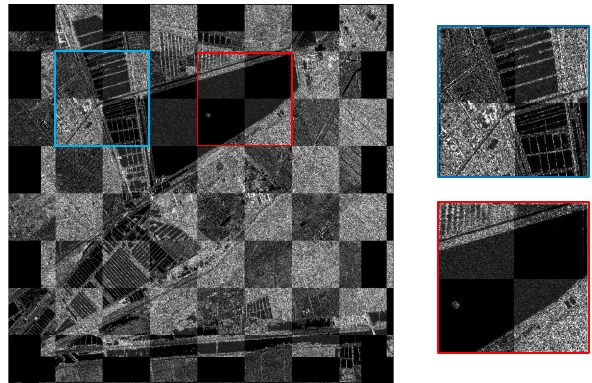
Figure 12. The Chessboard Diagram for YellowR2